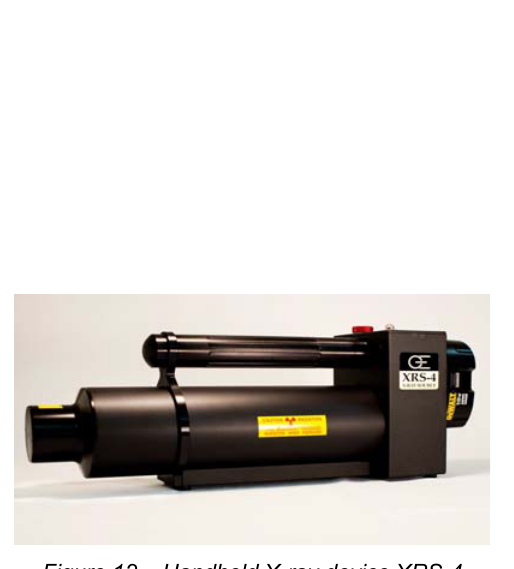
Figure 12 – Handheld X-ray device XRS-4 Рис . 12 – Переносной рентгеновский аппарат XRS-4 Слика 12 – Ручни рендген уређај XRS-4